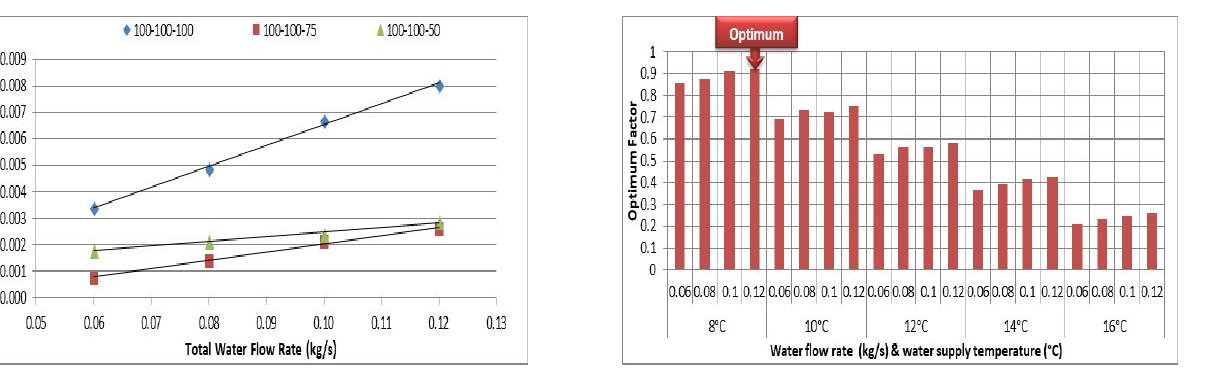
Fig. 17. Optimization factor of three-way valve case.